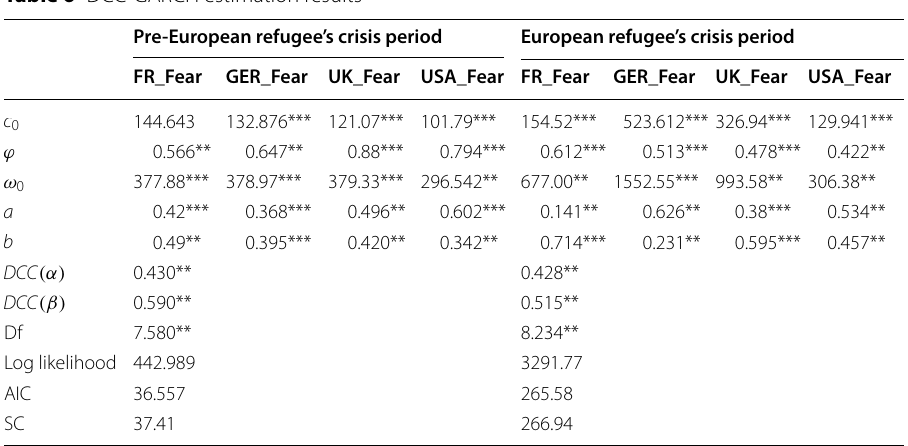
***, ** and * indicate respectively the signficance at 1%, 5% and 10%